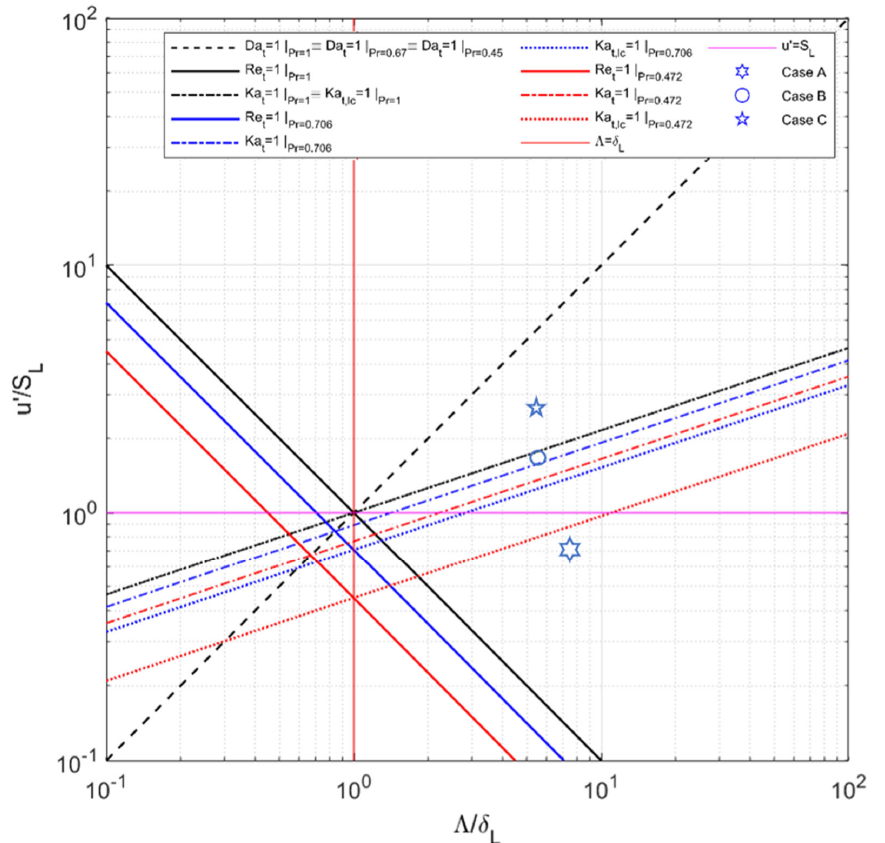
Figure 2. Regime diagram for premixed flames with traditionally defined axes. The different colours indicate a shift in 𝑃𝑟 ‐ dependent isolines. The dashed lines differentiate between the different dimensionless numbers. To provide examples of how the diagram is used, three simulation cases are positioned inside.